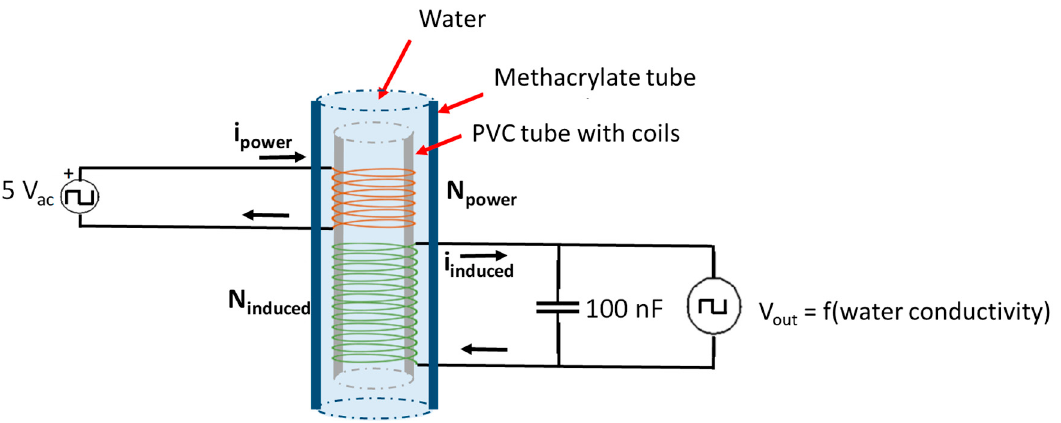
Figure 1. Diagram of our water salinity